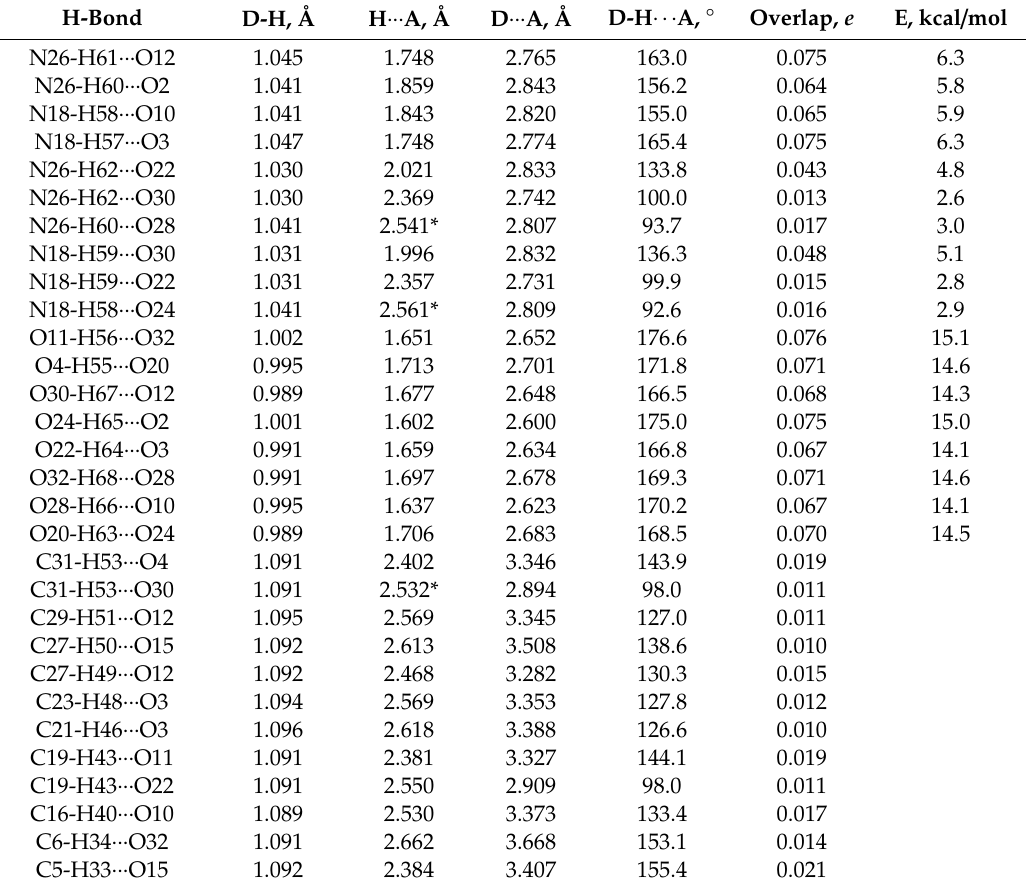
Table 2. The hydrogen bonds (CRYSTAL14) in fosfomycin tromethamine.